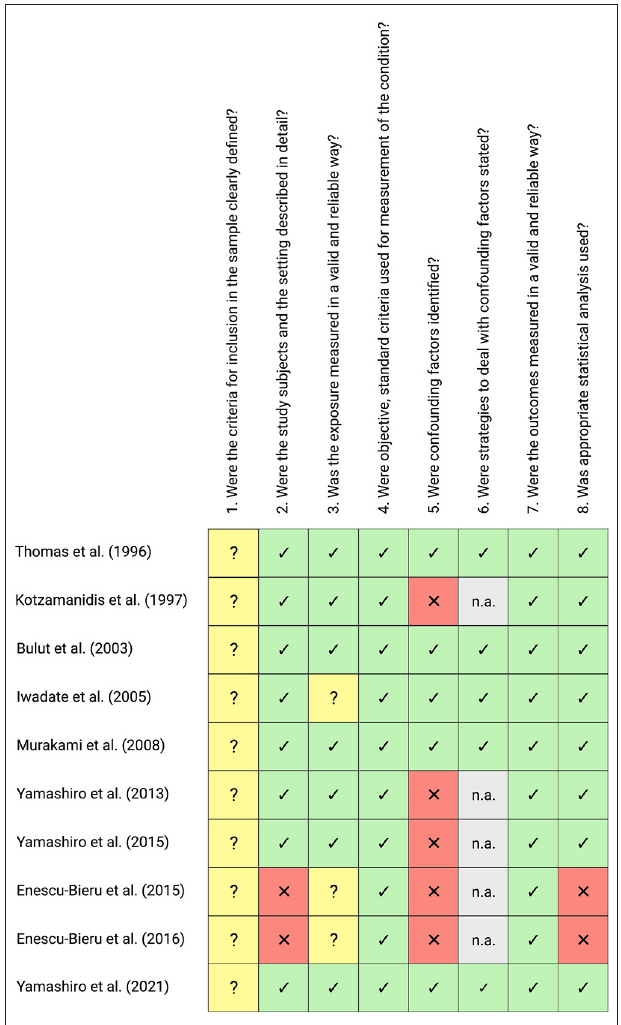
FIGURE 2 | Methodological quality assessment of all included studies using the JBI Critical Appraisal Checklist for Analytical Cross-Sectional Studies. The checklist consists of eight questions regarding the methodological quality of a study, with the following choices: yes (green cells with ticks), no (red cells with crosses), unclear (yellow cells with question marks) or not/applicable (n.a., gray cells). This figure was created with